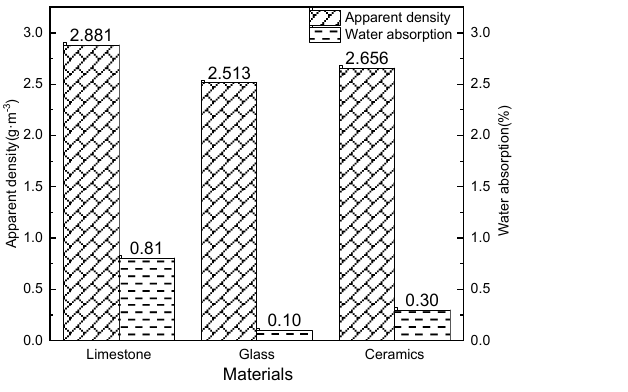
Figure 4. Physical properties of aggregates.